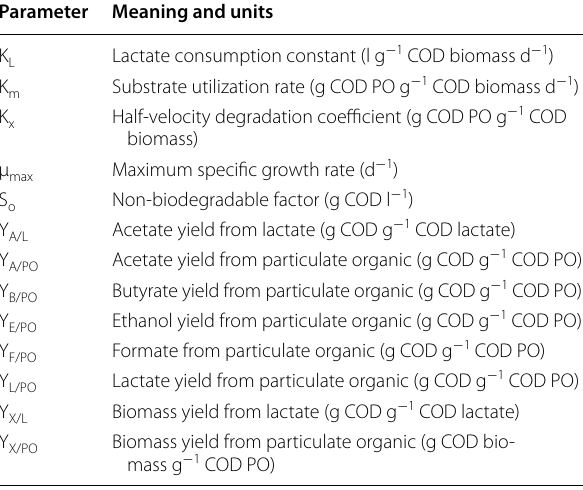
Parameter Meaning and units